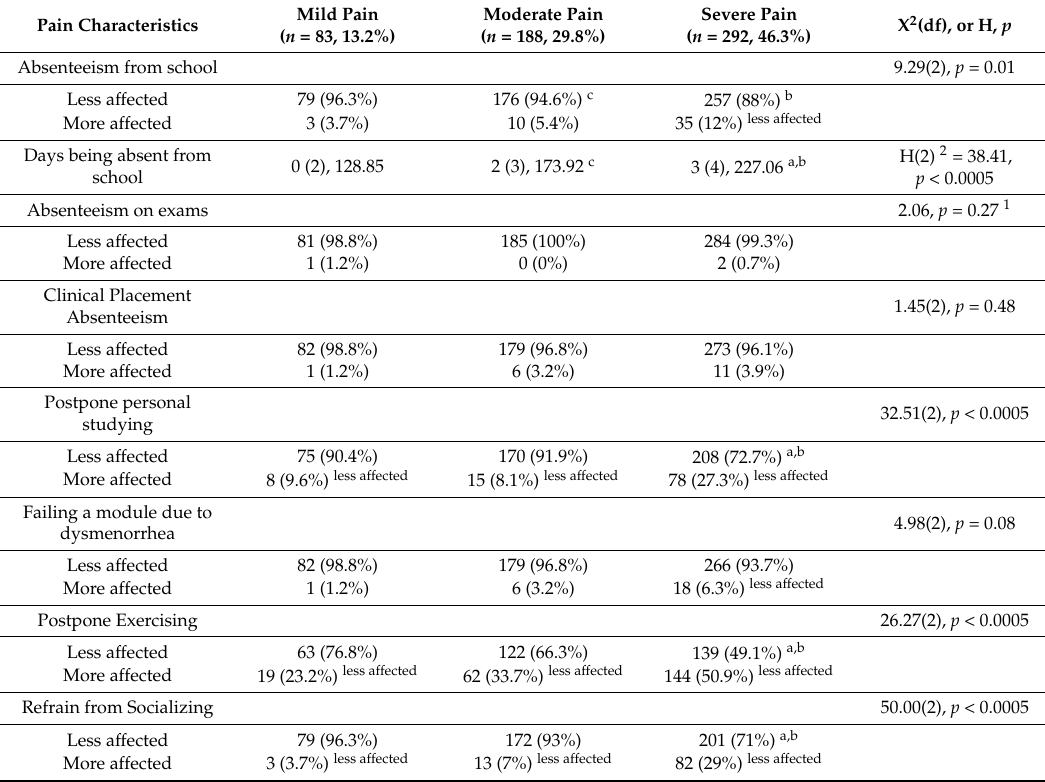
Table 5. Impact of Dysmenorrhea on functioning and wellbeing across pain intensity